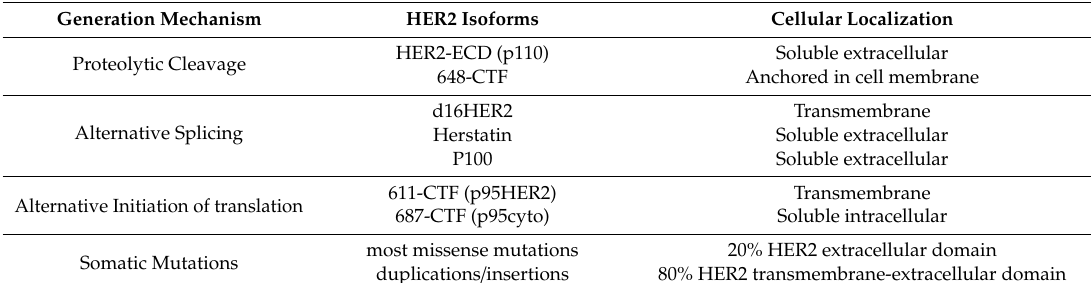
Table 1. Biodiversity of the proteome encoded by full-length